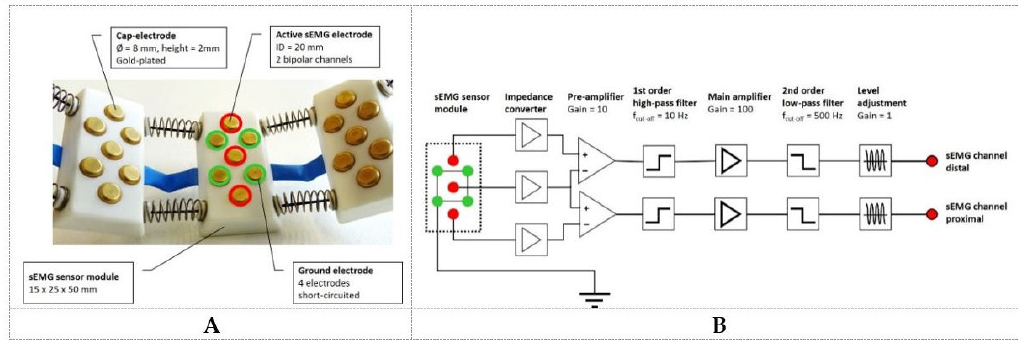
Figure 3. sEMG sensor module. ( A ) Each sEMG sensor module consist of seven gold-plated cap-electrodes. Four of them are short circuited to a ground electrode (green). The three active electrodes (red) are arranged along the center axis of the sensor module. They allow the recording of two bipolar sEMG channels, one distal and one proximal parallel to the bony axis of the limb. ( B ) Each individual sEMG sensor module incorporates a signal pre-processing unit that provides two sEMG channels for subsequent analog-to-digital